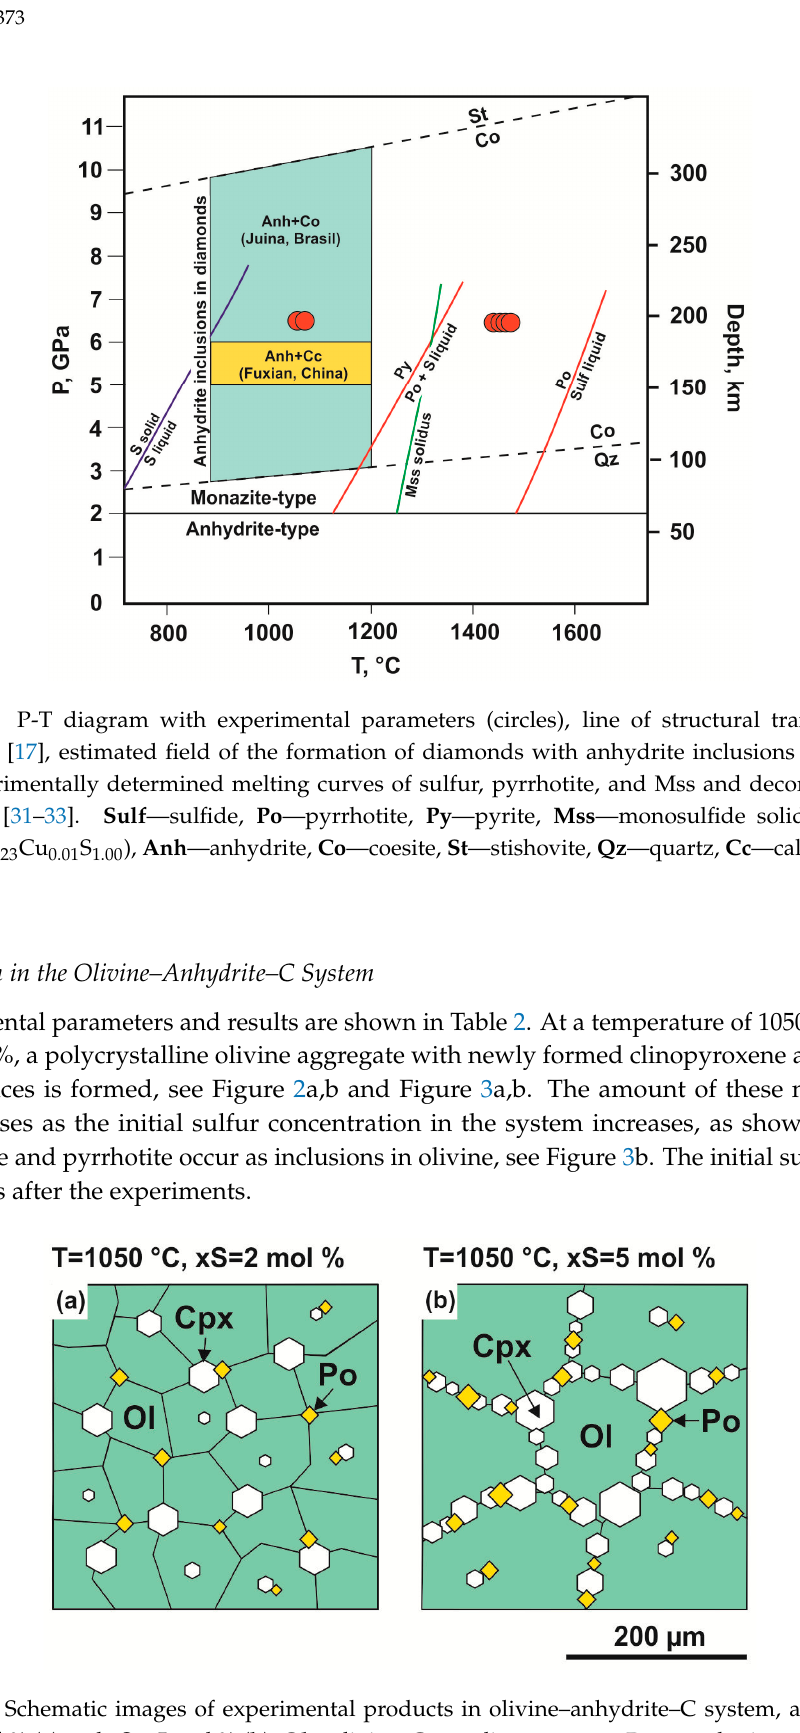
Figure 2. Schematic images of experimental products in olivine–anhydrite–C system, at 1050 °C, xS = 2 mol % ( a ) and xS = 5 mol % ( b ); Ol —olivine, Cpx —clinopyroxene, Po —pyrrhotite.